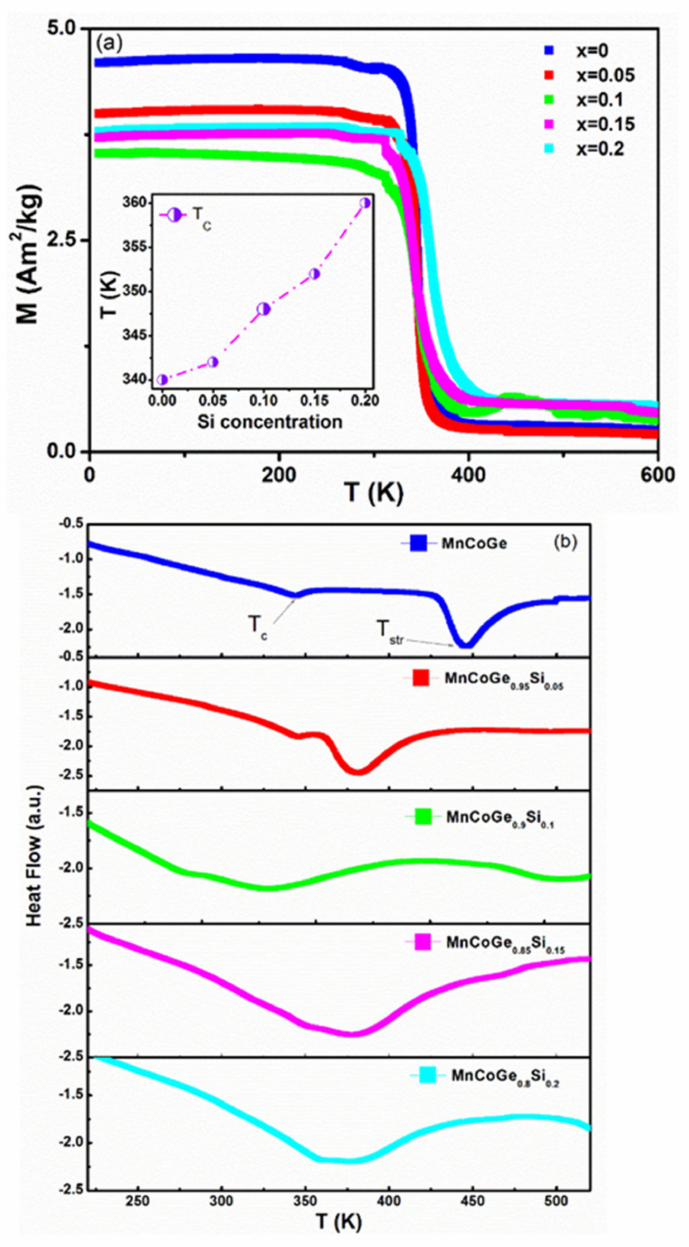
Figure 2. ( a ) M–T curves measured for MnCoGe 1 − x Si x (x = 0.05, 0.1, 0.15, and 0.2). The inset shows the pattern of Curie temperature with an increased Si concentration. ( b ) DSC curves measured ranging from 300 to 500 K. The arrows indicate the Curie temperature structural